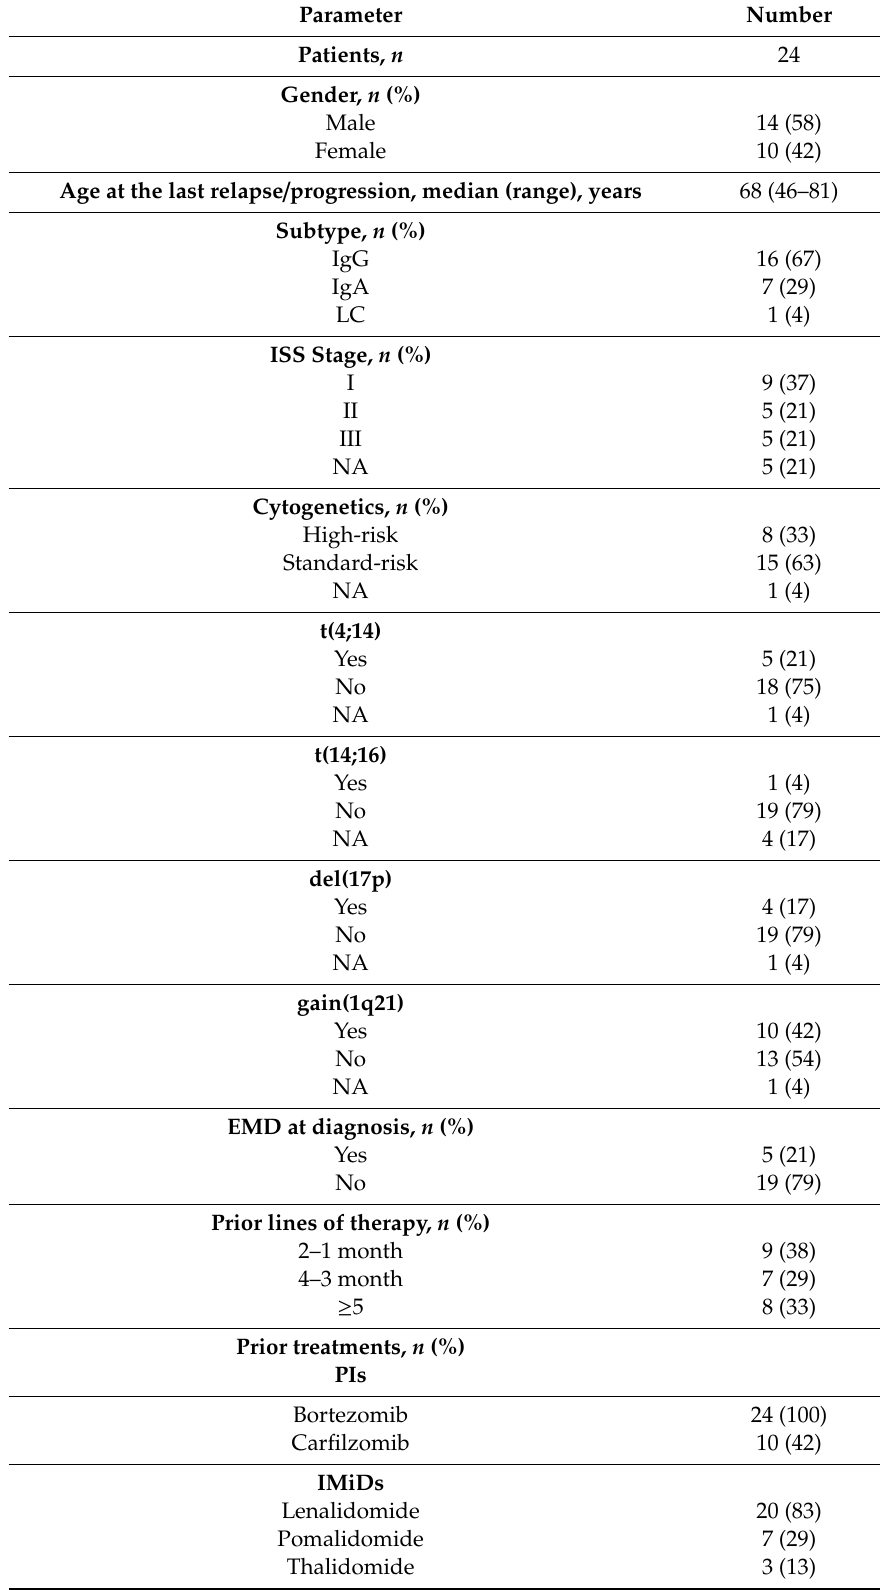
Table 1. Patients’